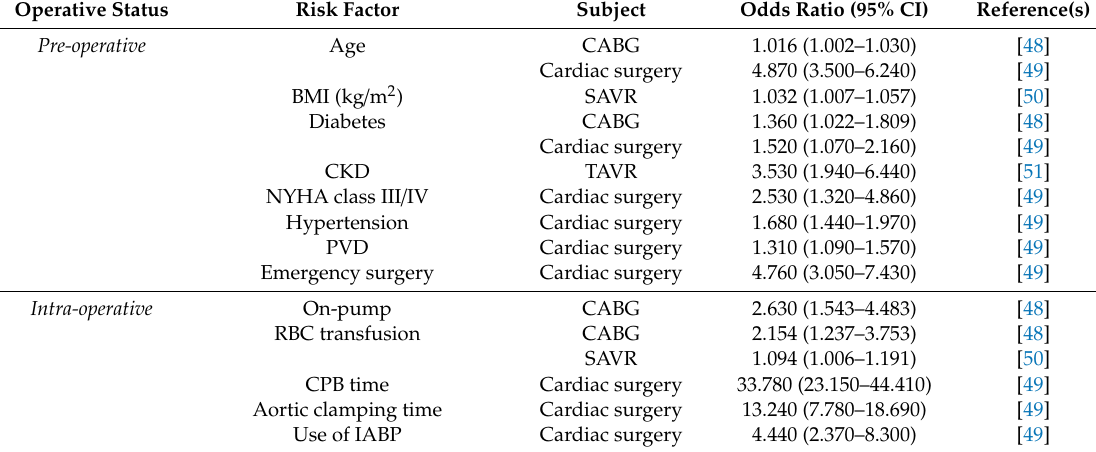
Table 2. Risk predictors for acute kidney injury following cardiac procedures and surgeries from multivariate